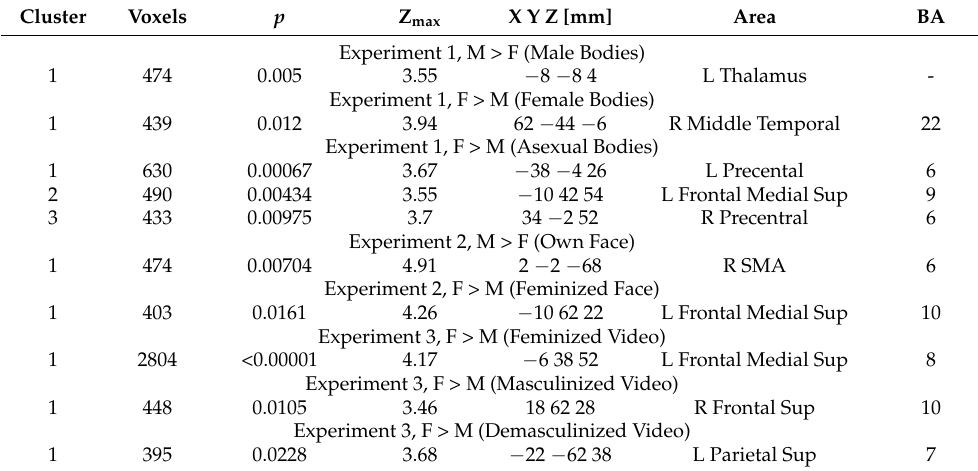
Figure 3. Group differences for the Body Projection experiment. First row Males greater than Females for male bodies, second row Females greater than Males for female bodies, and third row Females greater than Males for asexual bodies. In red significant clusters ( p corr < 0.05) on a gray matter ICBM brain template, neurological convention, color scale in the bar maps for Z scores. In blue MNI coordinates in mm, and lines to show the slice positions on the orthogonal projections (right side of the figure). Table 1. Group differences for different experiments and